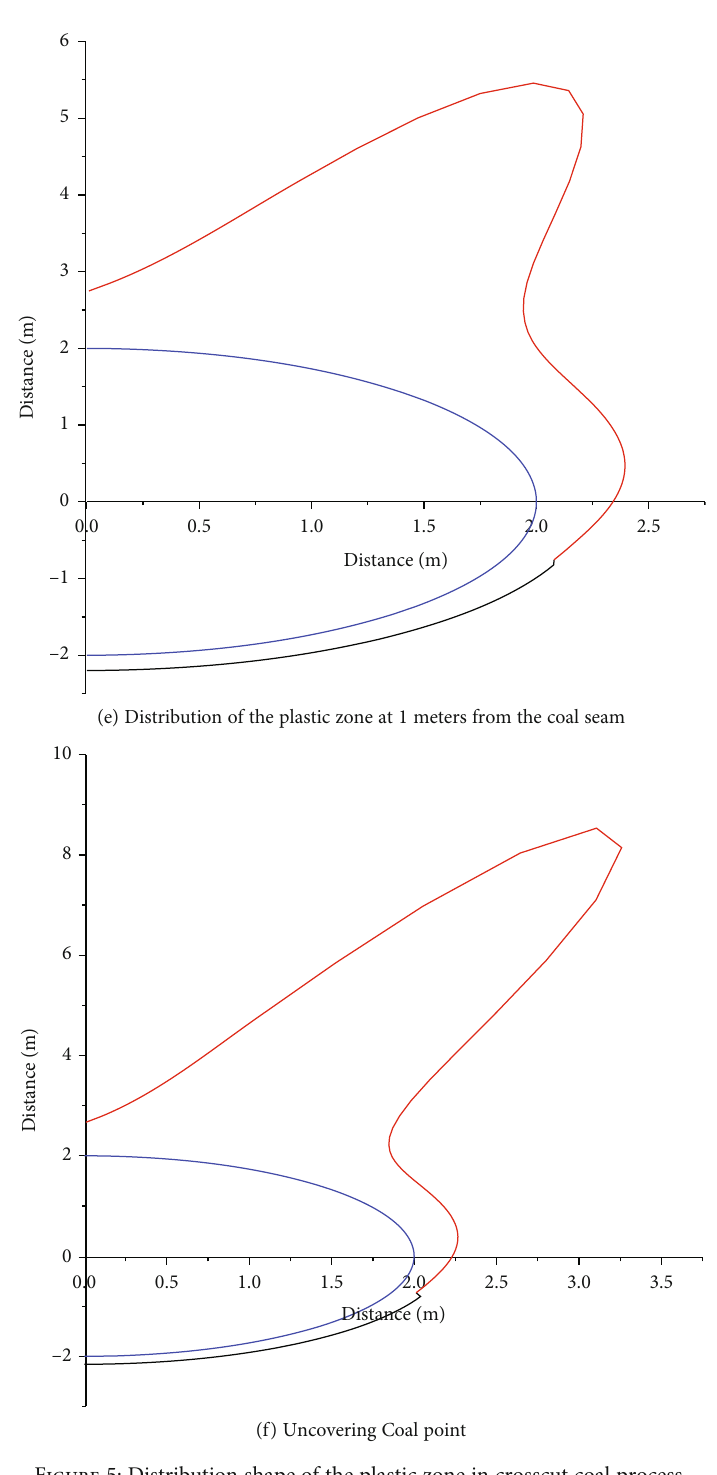
Figure 5: Distribution shape of the plastic zone in crosscut coal